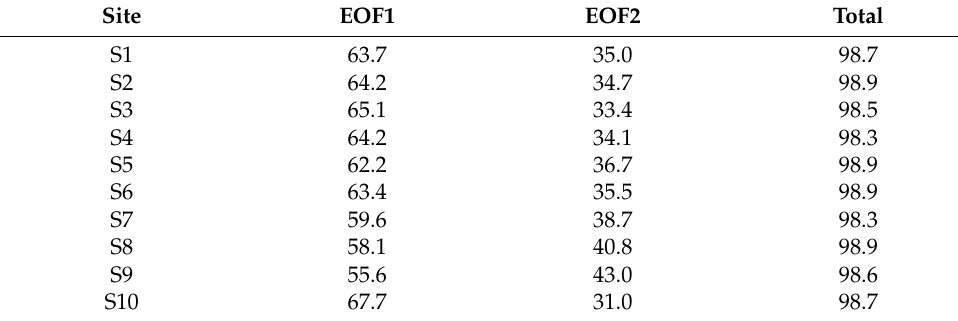
Table 3. Percent variance explained by the first two EOFs at each